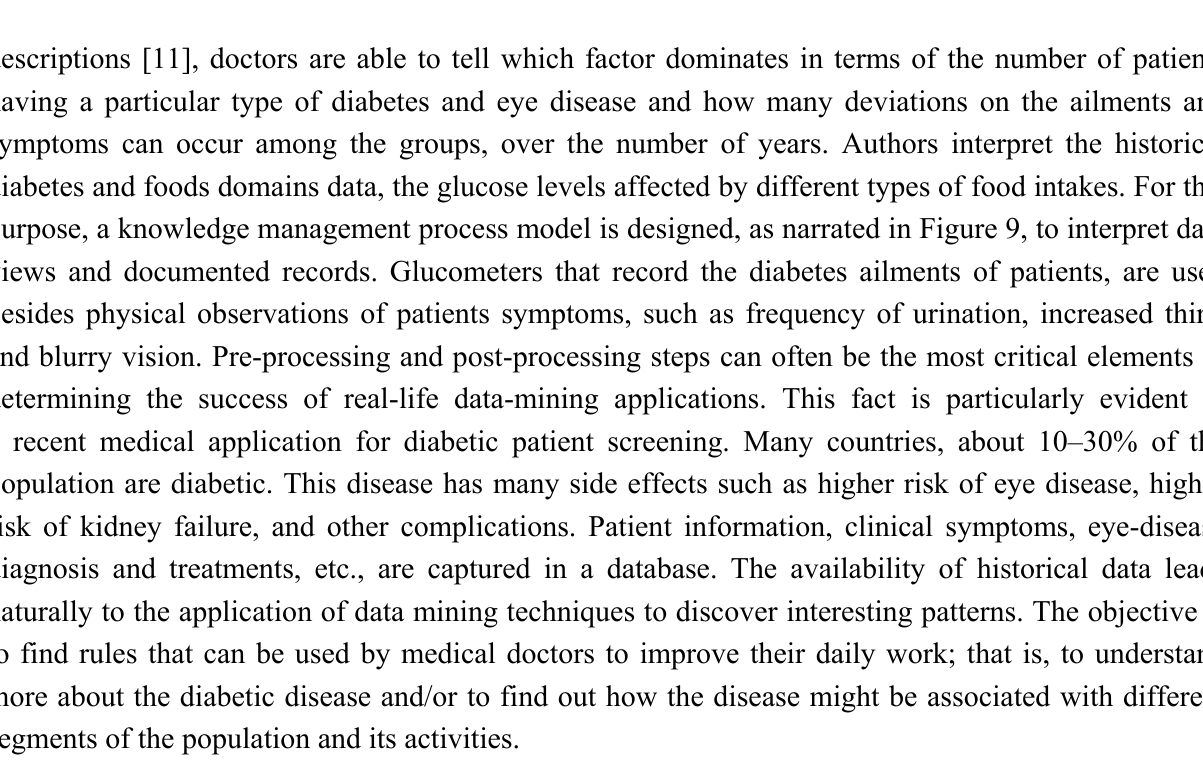
Figure 9. Knowledge management process